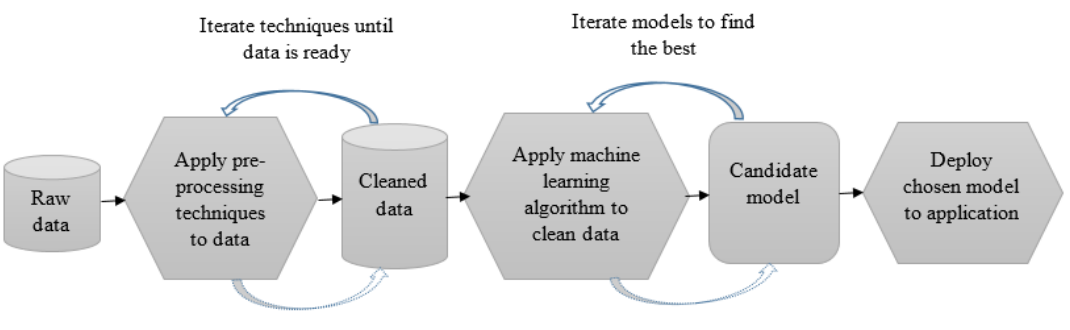
Figure 3. Predictive analytics and modeling